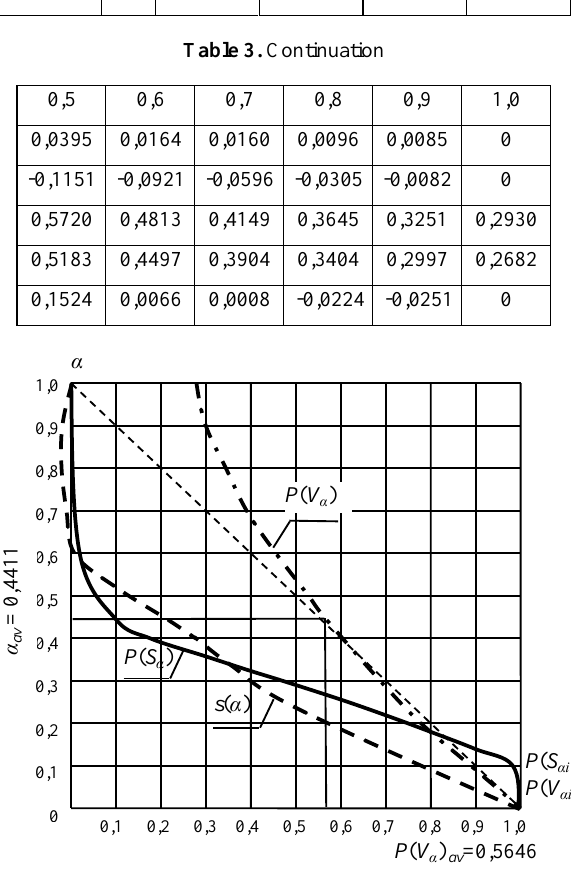
Fig. 8 . P(Sα), P(Vα) and s(α) curves constructed for the third section of the profilogram depicted on fig. 2).